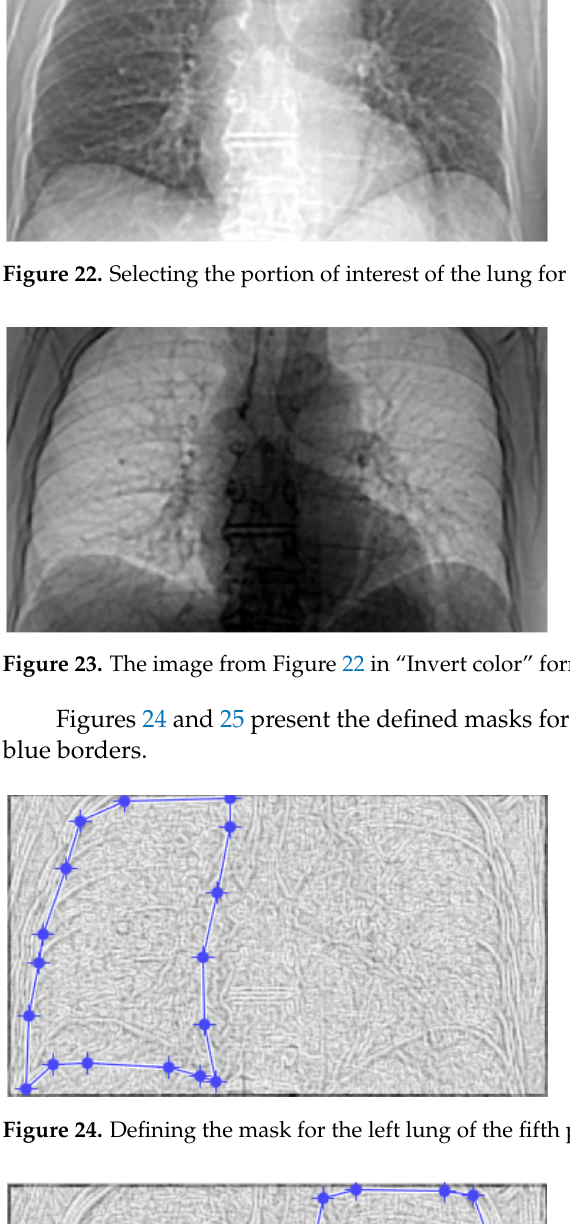
Figure 21. Three-dimensional graphical representation of voxels in the fourth patient(cid:31)s CT lung image.